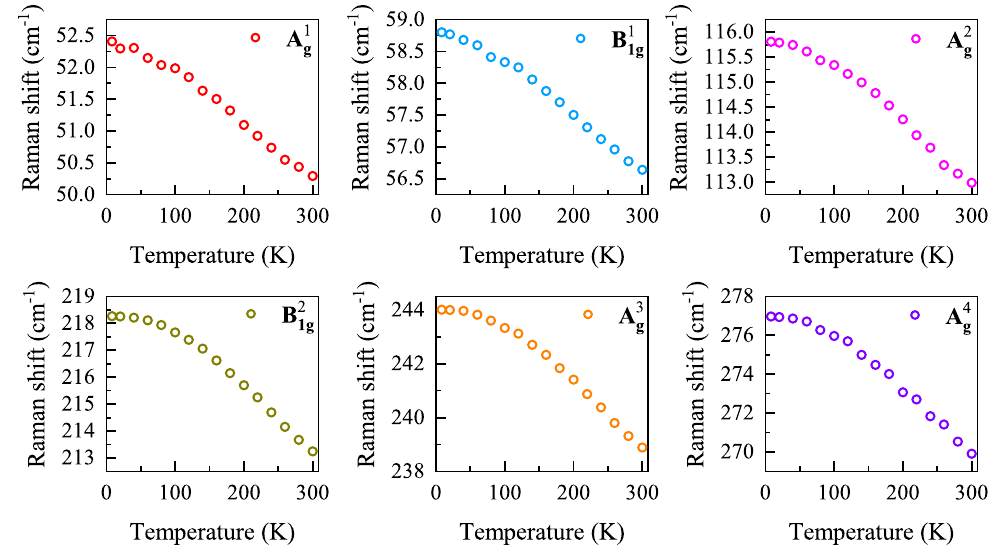
Figure A2. Temperature evolution of the Raman shifts for the all observed phonon